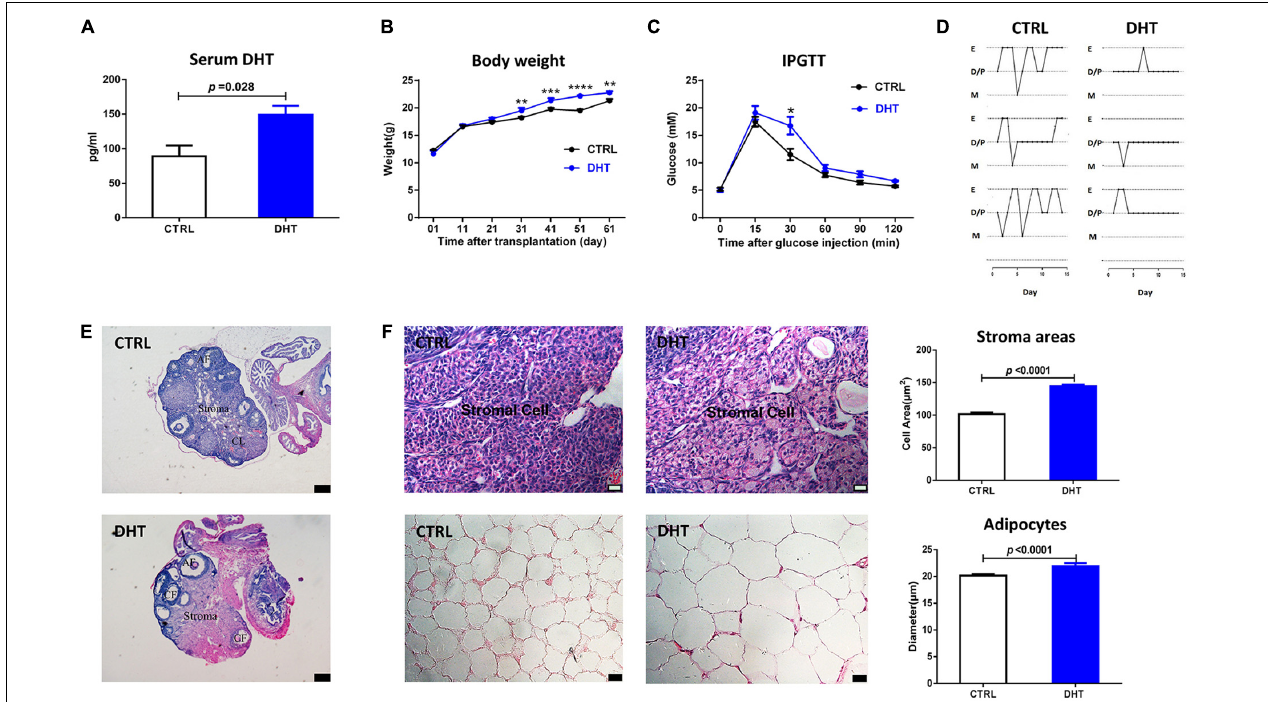
FIGURE 1 | PCOS-like characteristics in DHT-treated mice. (A) Serum DHT level. (B) Body weight changes in mice. (C) Blood glucose changes in the IPGTT. (D) Estrous cycles. (E) Typical histological image of hematoxylin and eosin (H&E)-stained ovaries (corpora lutea, CL, cystic follicle, CF, antral follicle, AF, scale bars = 200 µ m). (F) Morphology and mean size of ovarian stroma areas and adipocytes; n = 6. mean ± S.E.M. Mann-Whitney U -test for (A,F) , Duncan’s multiple range test for individual comparison repeated measures ANOVA test for (B,C) , ** p < 0.01, *** p < 0.001, **** p <